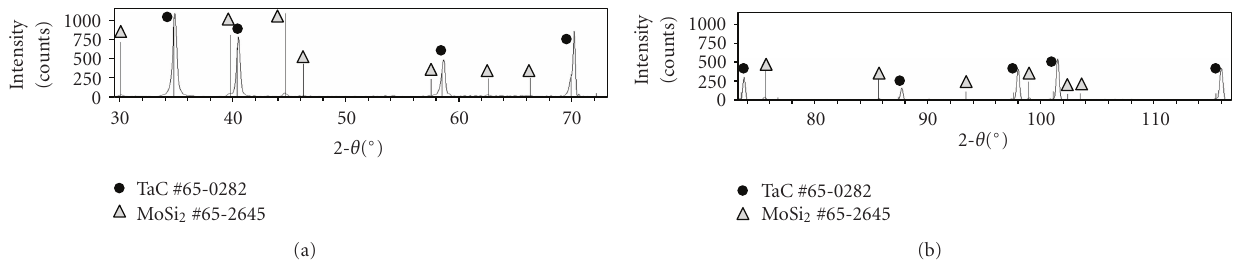
Figure 7: X-ray di ff raction pattern of TC20. Superimposed PDF lines corresponding to TaC and MoSi 2 ; note the peaks shift of the TaC phase in the composite.